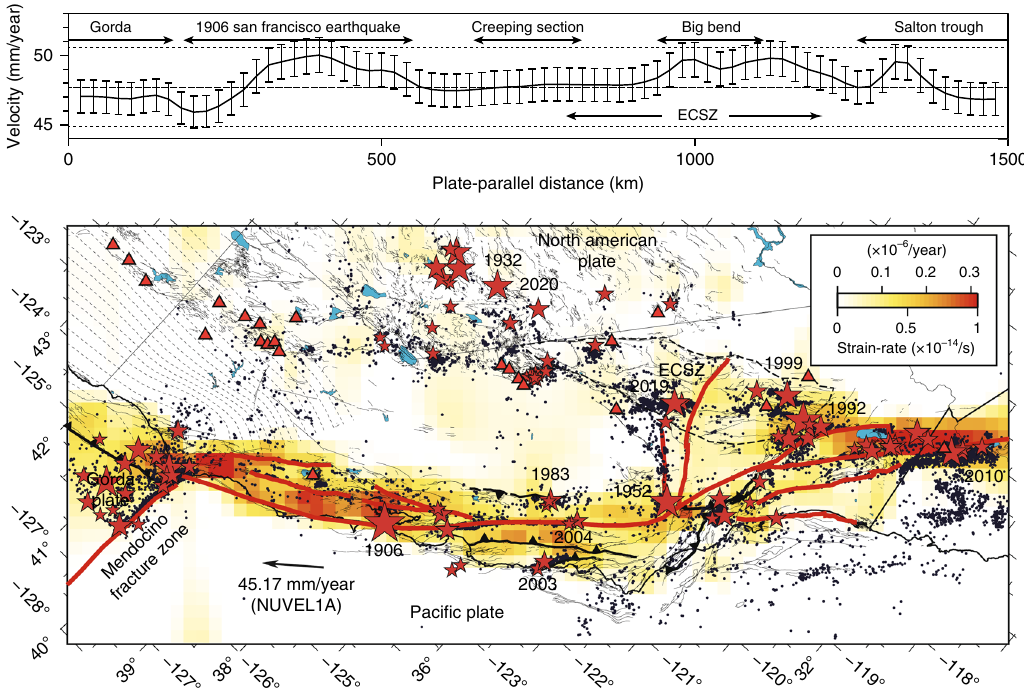
Fig. 9 Strain partitioning across the San Andreas fault system. The top panel shows the plate parallel velocity from the integration of the shear component of the strain-rate tensor in the plate-perpendicular direction. The dashed lines indicate the average velocity and (1- σ ) standard deviation of the Paci fi c plate relative to the North American plate from 18 different models, including REVEL-2000, NUVEL 1A, ITRF 2008, and MORVEL 2010 (refs. 76 – 79 ). The bottom panel shows the distribution of deep shear strain-rate in California from the Mendocino triple junction to the Salton trough, highlighting the strain partitioning primarily between the San Andreas fault and the Eastern California Shear Zone. The red stars and black circles show the hypocenter of historical earthquakes and earthquakes from moment magnitude 3 and above from 1990 to 2020 around California, respectively. The seismic catalog is obtained from the Northern California Earthquake Data Center (https://ncedc.org) and the Southern California Earthquake Data Center (https://scedc. caltech.edu). The gray dashed pro fi les correspond to the 5-km depth contours of the Cascadia megathrust. Red triangles indicate quaternary